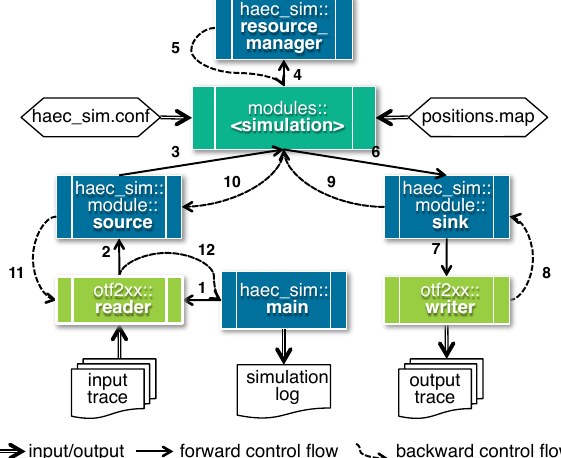
Figure 3: Software control flow in HAEC-SIM.